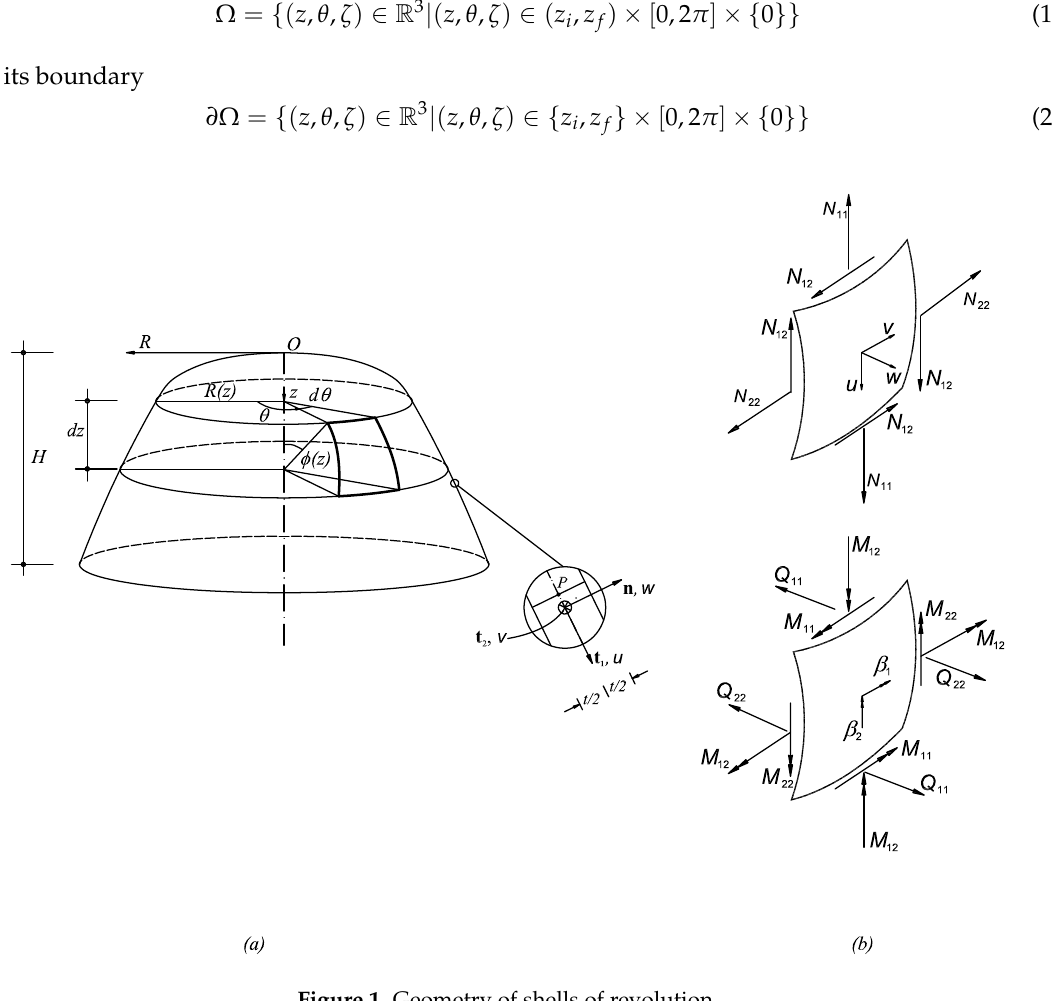
Figure 1. Geometry of shells of